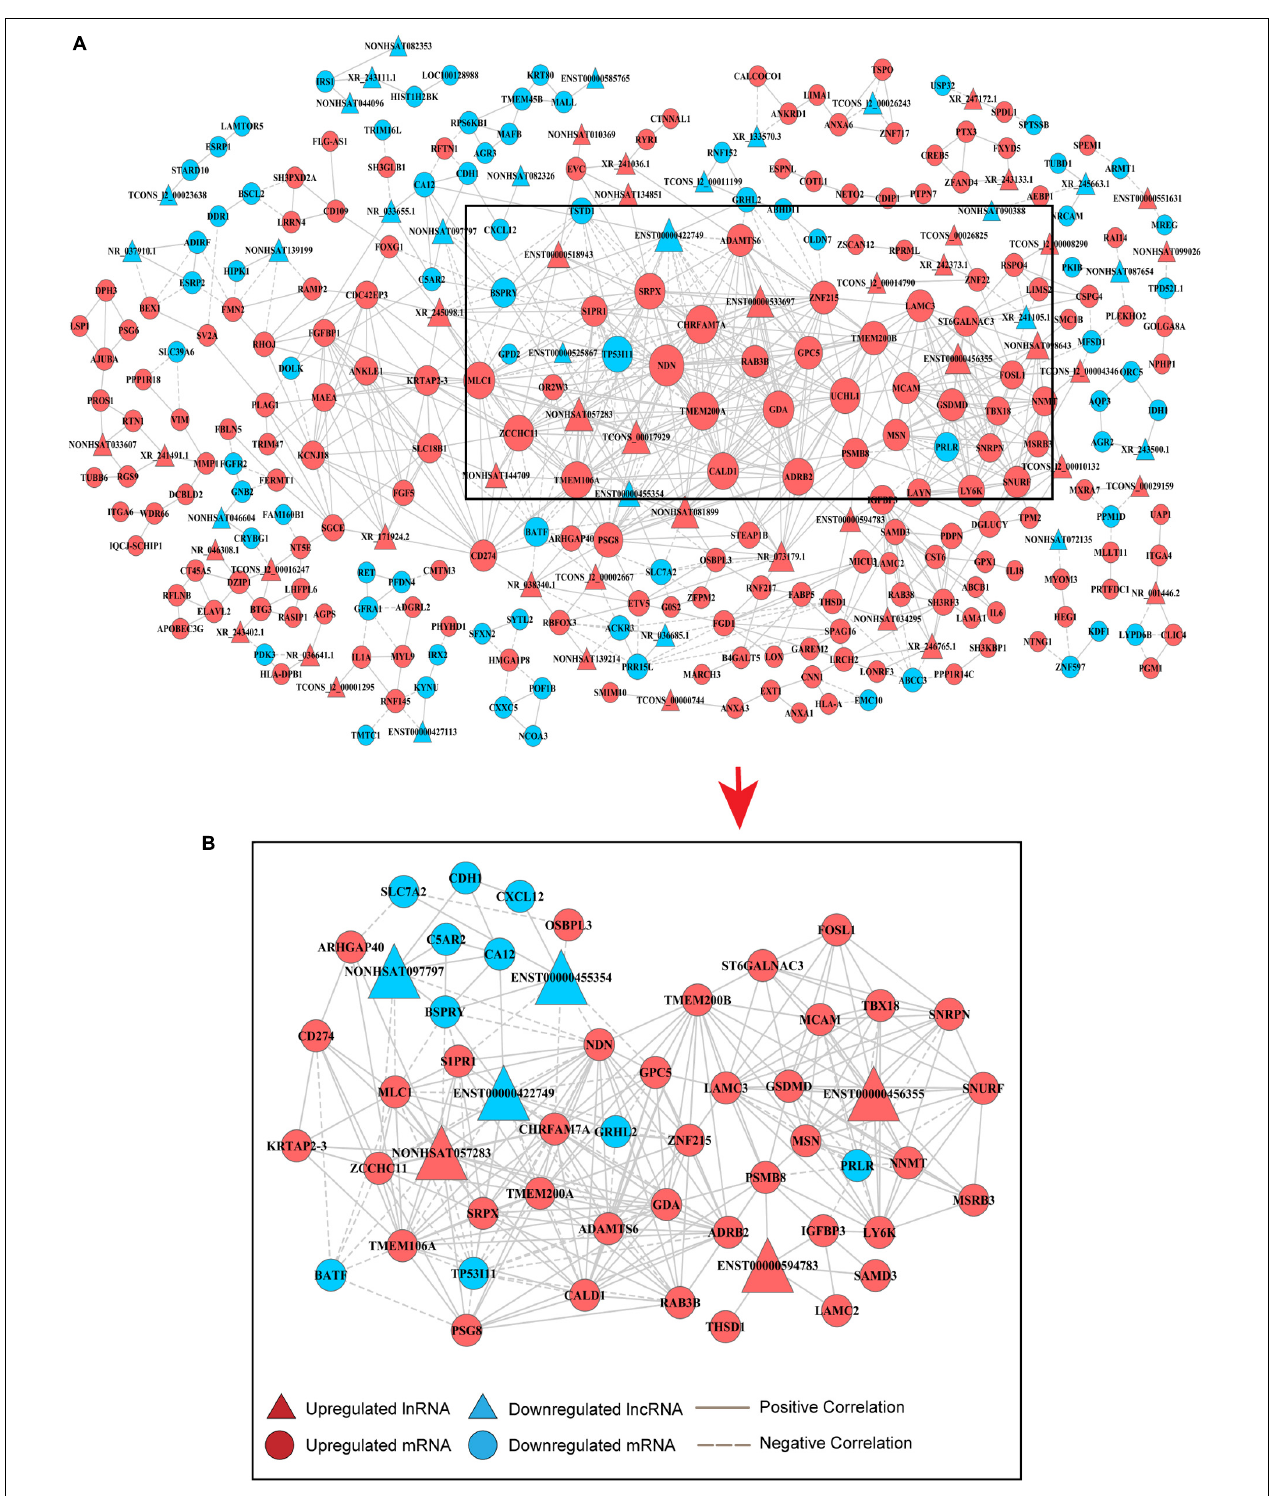
FIGURE 2 | Coexpression network of DE-lncRNAs and DE-mRNAs for predicting the functional roles of candidate lncRNAs. (A) Overview of the coexpression network comprising lncRNA associations with mRNAs. The key genes in the center of the network are in the black triangle area. The red colored genes represent upregulated lncRNAs and mRNAs, while the blue color indicates downregulated genes. Positive correlations are represented by a solid line, and negative correlations are represented by a dotted line. Data are expressed using the comparative cycle threshold method. (B) The subnetwork in the black area above was selected to show the relationship between candidate hub lncRNAs and